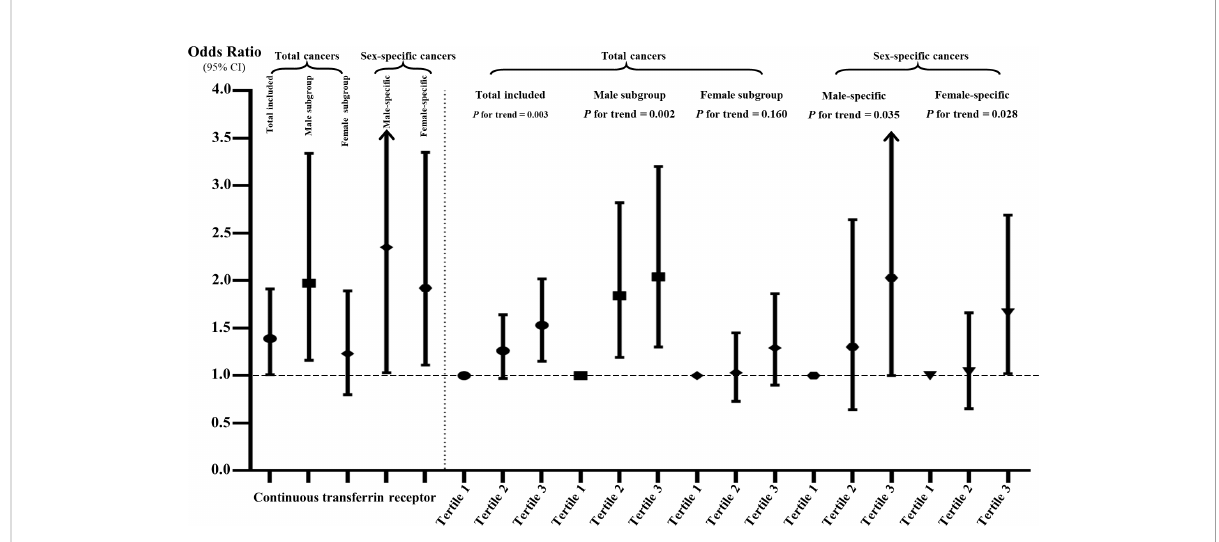
FIGURE 3 The associations of sTfR with total and sex-speci fi c cancers in continuous and tertile analyses after full adjustment. The sTfR concentrations were ln-transformed in the continuous